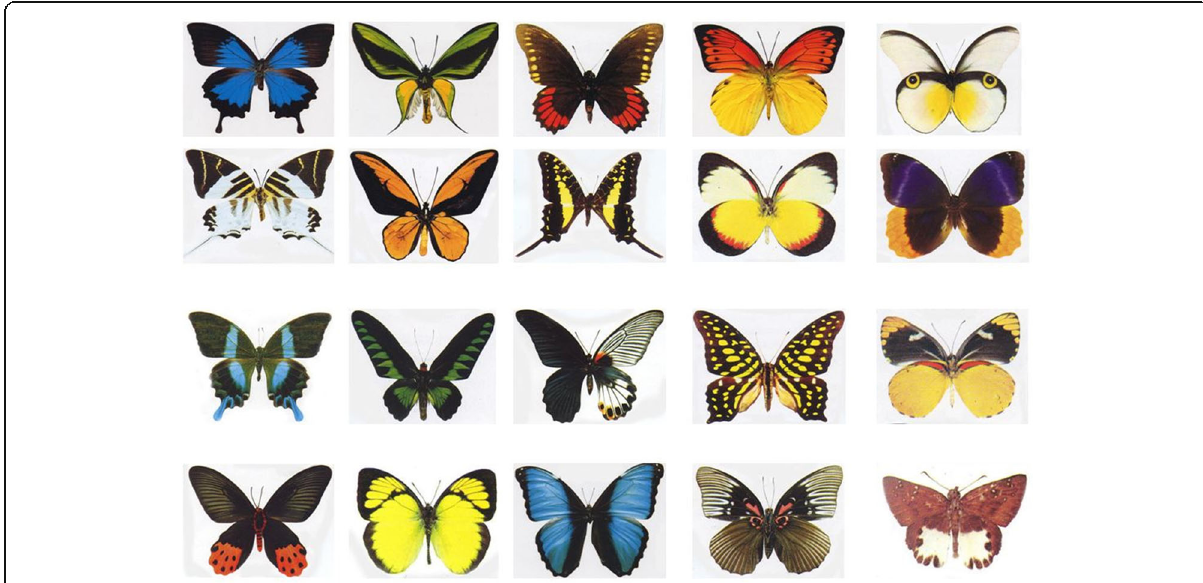
Fig. 18 Some of butterfly color images used in the image classification